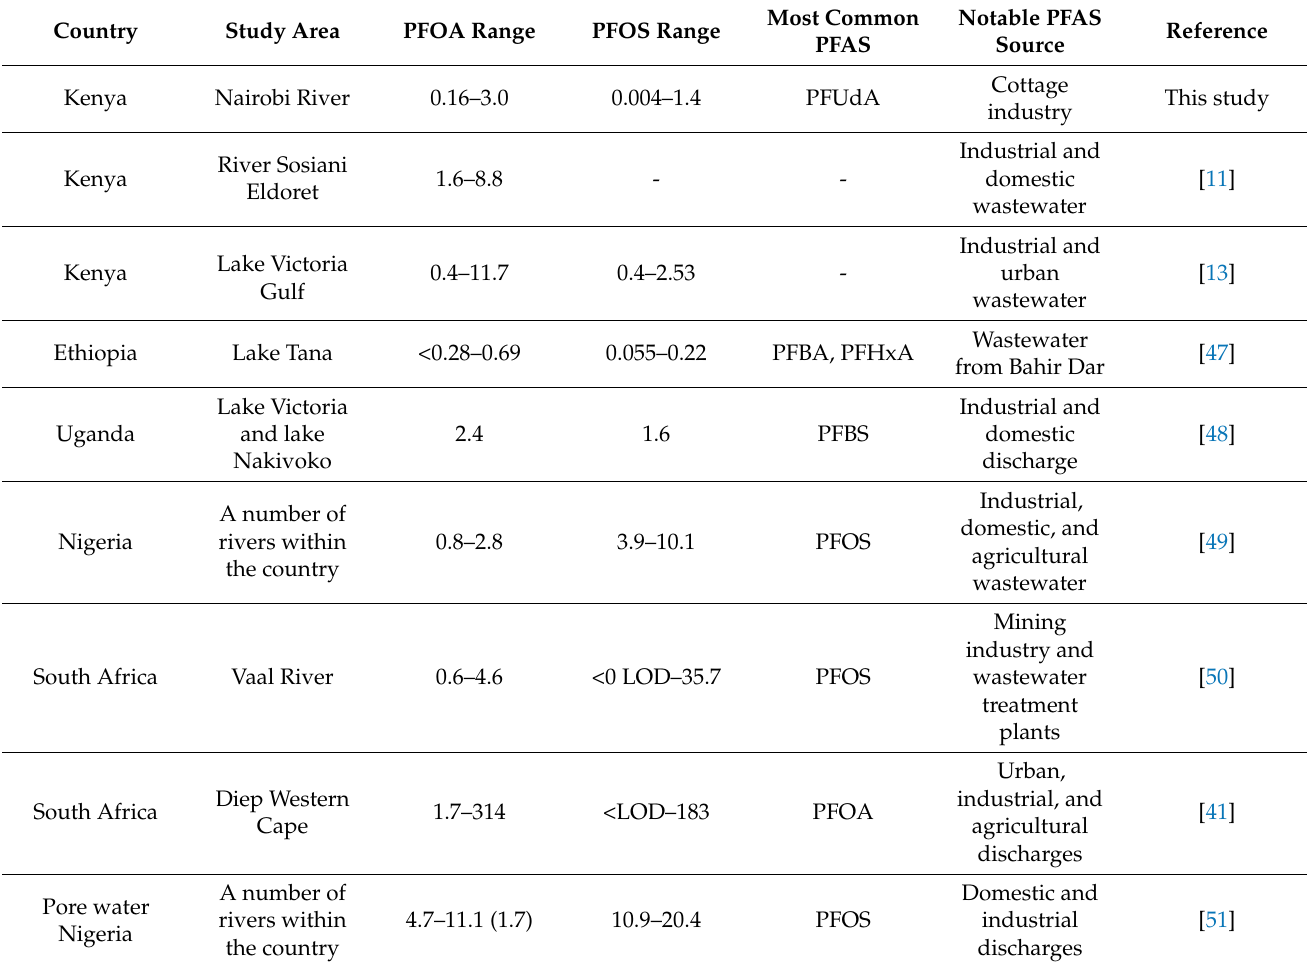
Table 3. Comparison of the levels of PFAS in surface water in this study and other studies in Africa.